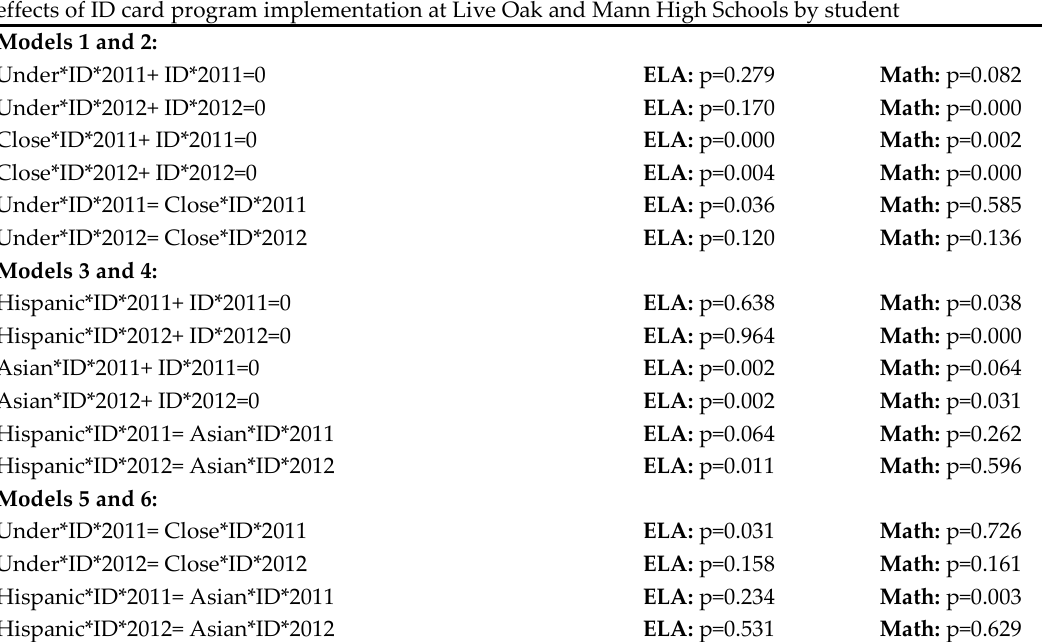
Table S5: Supplemental tests of statistical significance for difference-in-difference estimates of average effects of ID card program implementation at Live Oak and Mann High Schools by